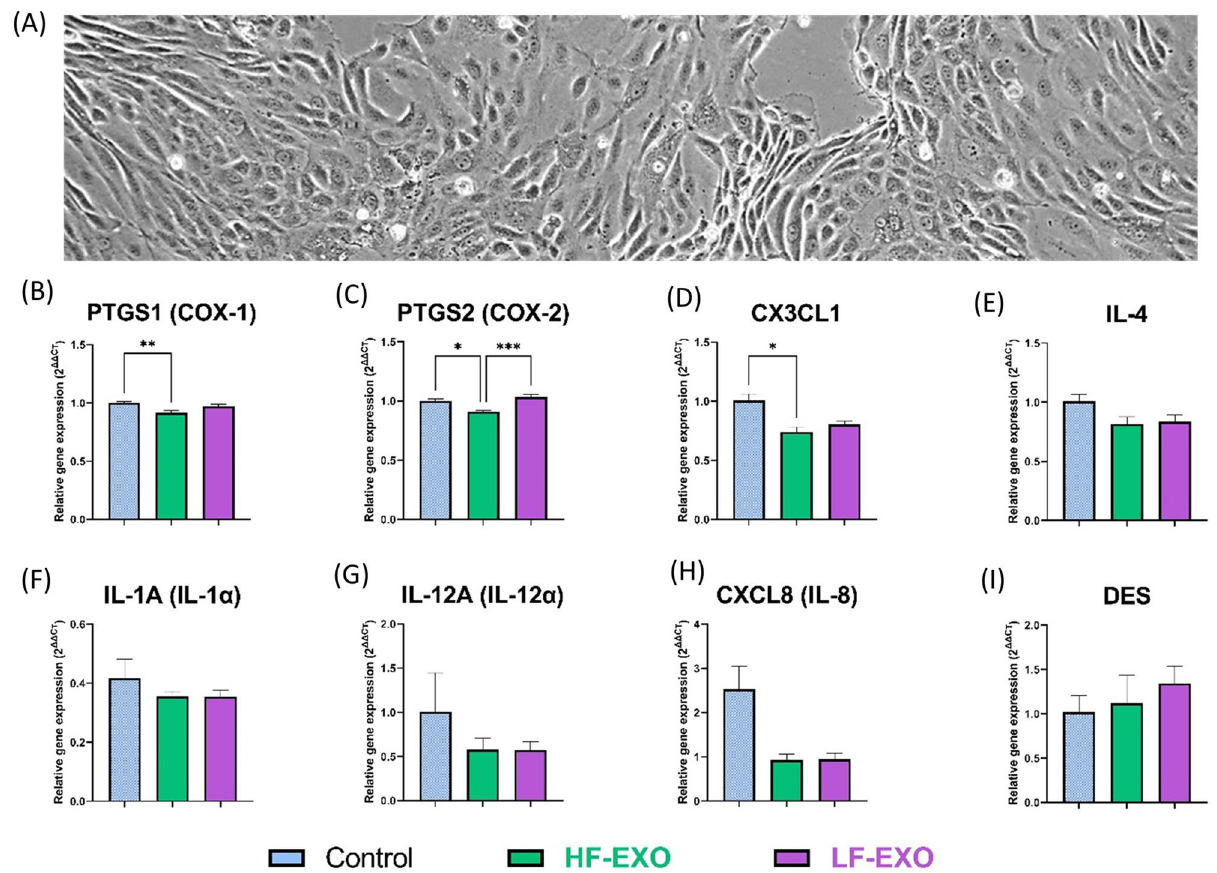
Figure 3. Co-incubation with sEV from dairy cows identified as high fertile (HF-EXO) and low fertile (LF-EXO) lead to differential gene expression in bovine endometrial epithelial (bEEL) cells. ( A ) bEEL cells depicts columnal or cuboidal morphology and showed contact inhibition after confluency (at 48-h, 10X). ( B,C ) Prostaglandin synthase enzyme gene expression, ( D,E ) anti-inflammatory mediator gene expression ( F,I ) pro- inflammatory mediator gene expression in bEEL cells. Values are presented as mean ± SEM. Brown-Frosythe and Welch ANOVA test along with Dunnett’s T3 multiple comparison was selected as post-hoc test to identify statistical significance differences between the groups. *P ≤ 0.05, **P ≤ 0.01, ***P ≤